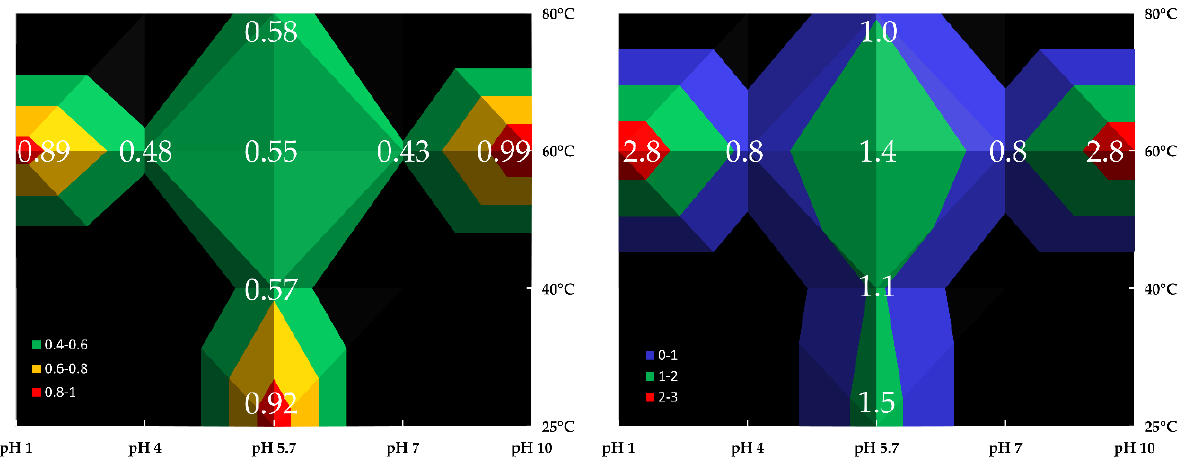
Figure 13. Effect of pH and temperature on the dissolution rate constant ( left ) and the dissolution activation energy ( right ). Black areas represent the absence of data.